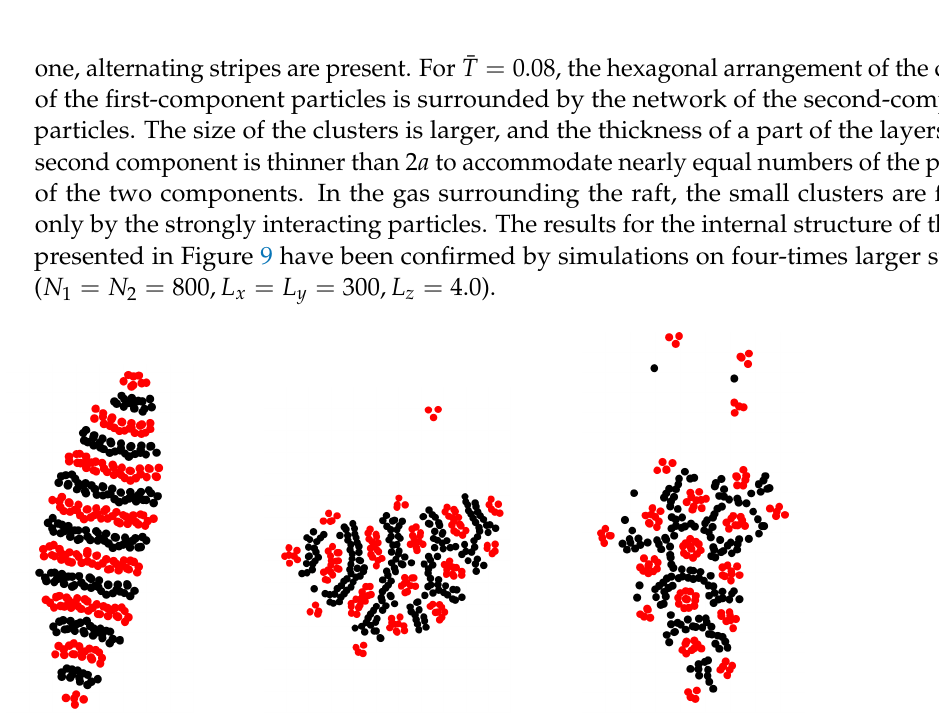
Figure 9. Representative configurations in the layer self-assembled between repulsive walls in the continuous model (3) for N 1 = N 2 = 200, L x = L y = 150, and L z = 4. A projection on the ( x , y ) plane is shown for a part of the simulated system. The red and black circles represent the first and the second component. ( Left ) raft: q = 1 and ¯ T = 0.12. ( Central ) raft: q = 1/2 and ¯ T = 0.06. ( Right ) raft: q = 1/2 and ¯ T =